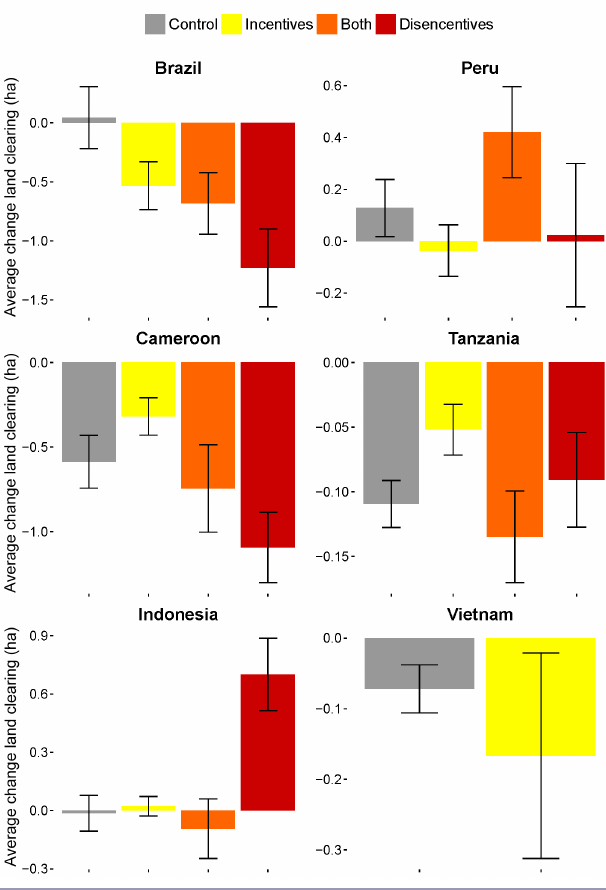
Fig. 3 . Difference in reported forest clearing from phase 1 to phase 2 by households targeted by different intervention